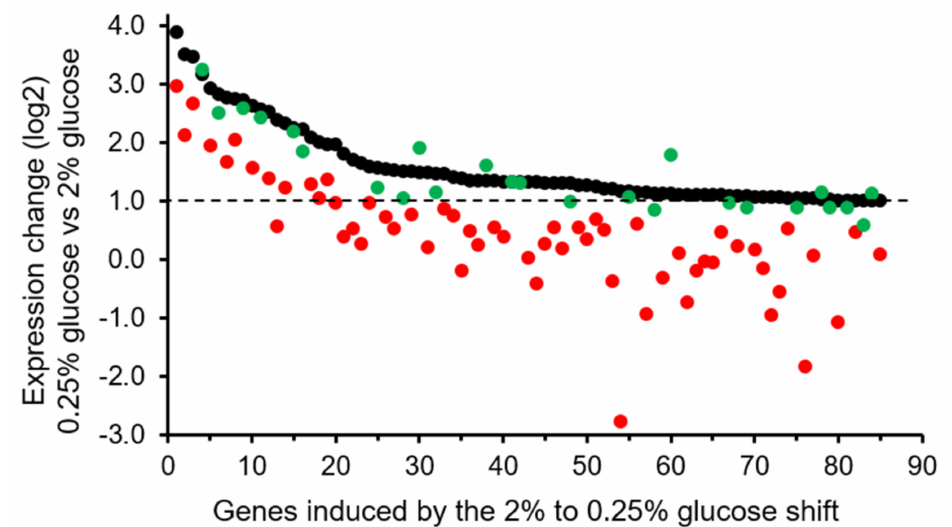
Figure 1. Expression changes for the set of 85 genes found induced by the shift from medium containing 2% glucose to medium containing 0.25% glucose (black circles). The expression changes for each of these genes in response to the shift when PPZ1 was overexpressed are also plotted for genes affected (red circles) or unaffected (green circles) by the overexpression of the phosphatase (unpublished results, data can be retrieved from Gene Expression Omnibus (GEO) under accession code GSE199793). A dotted line is drawn to better distinguish upregulated